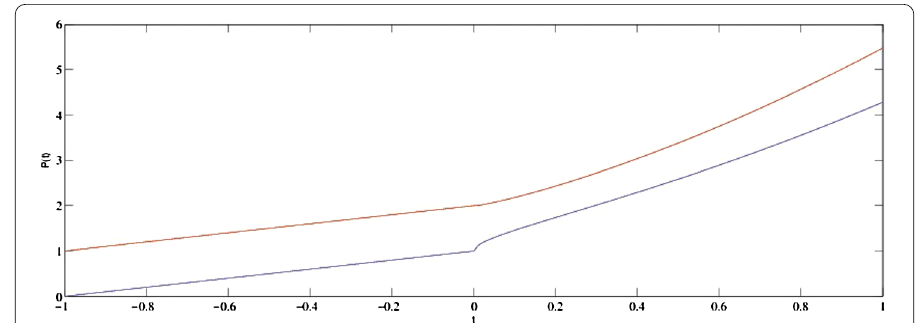
Figure 1 The w -increasing solution of Example 3.5 in Case 1.